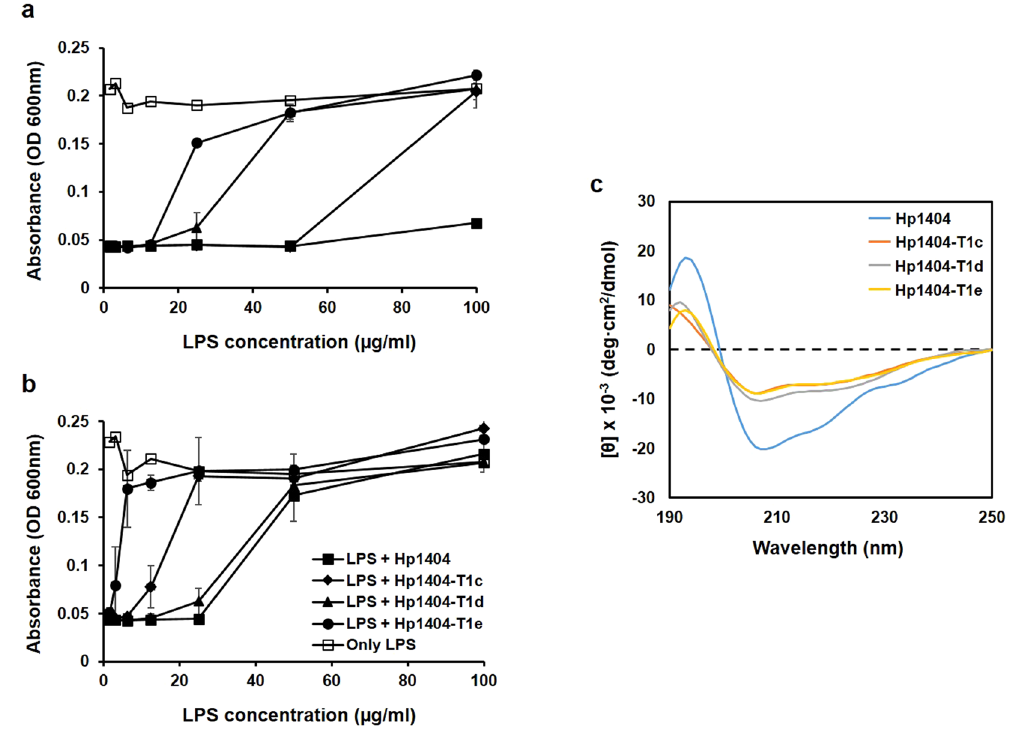
Figure 4. LPS binding assay. Affinities of peptides toward LPS were examined by determining the effect of increasing LPS concentrations on their antimicrobial activities at ( a ) 1 × MIC, and ( b ) 2 × MIC, against P. aeruginosa . ( c ) CD spectra of peptides in 0.1% LPS suspensions. The peptide concentration was fixed at 40 µ M. Each experiment was repeated three